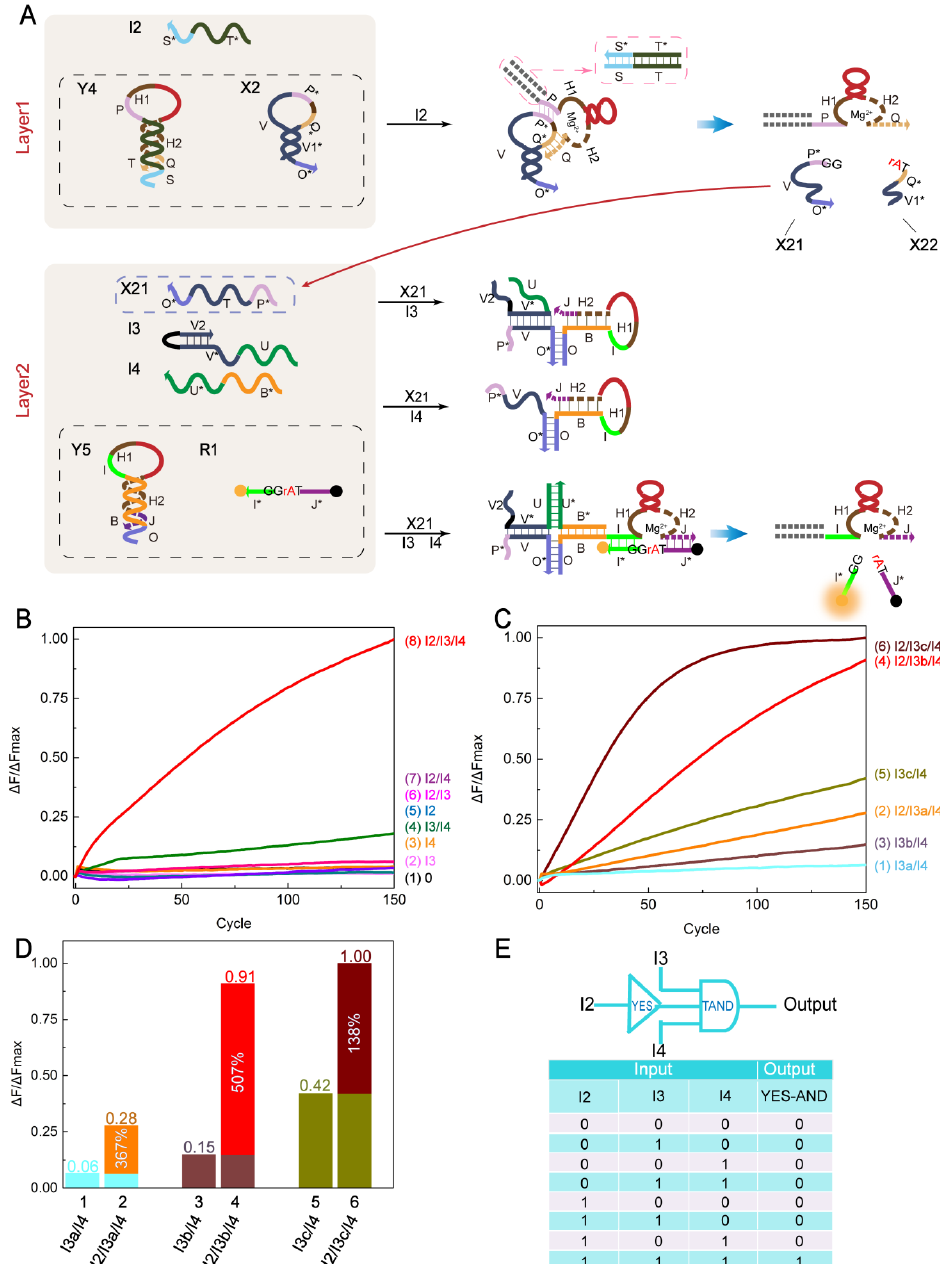
Figure 5. ( A ) Schematic of the YES-TAND logic circuit. Layer2 only shows the reaction with Y5. ( B ) Time-dependent normalized fluorescence intensity change ( ∆ F / ∆ FMax) at di ff erent inputs. Curves 1–8 reflect the change in fluorescence of YES-TAND at di ff erent inputs. The sampling interval is 6 min, 100 cycles. All data represent the average of three replicates. ( C ) Time-dependent normalized fluorescence intensity change ( ∆ F / ∆ FMax) when the input strand I3 sequence is di ff erent. Curves 1, 3 and 5 reflect changes in fluorescence in the absence of I2, with the V and V* domains of I3 having 8 bp, 7 bp and 0 bp complementarity, respectively. Curves 2, 4, and 6 reflect the change in fluorescence in the presence of I2, corresponding to curves 1, 3, and 5, respectively. I4 was present in all tubes of this experiment. The sampling interval is 6 min, 100 cycles. All data represent the average of three replicates. ( D ) Statistical analysis of the number of bases in the V2 region of I3 in Layer2 (corresponding to Figure C). Comparing the leaks of columns 1, 3, and 5, the percentage of relative fluorescence increase is indicated in columns 2, 4, and 6 (( ∆ F(1) – ∆ F(0)) / ∆ F(0)%), respectively. The response time is 15 h. ( E ) YES-TAND logic circuit logic symbol and truth